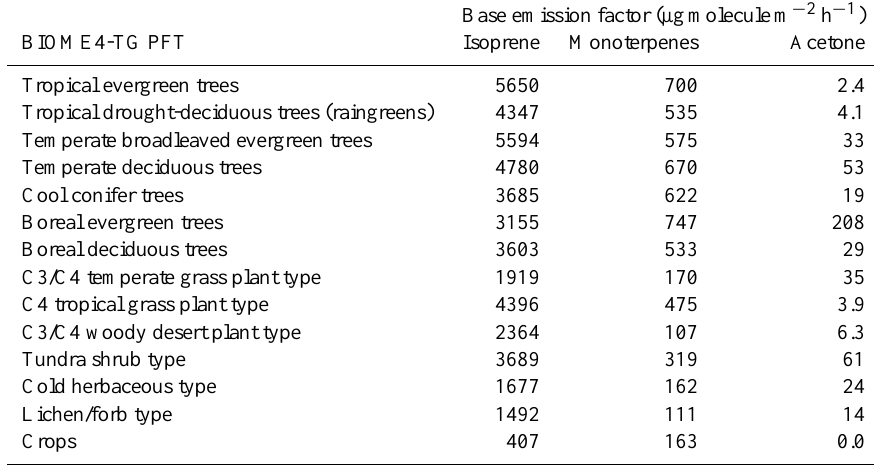
Table 5. Biogenic emission factors used for plant functional types in the dynamic vegetation model